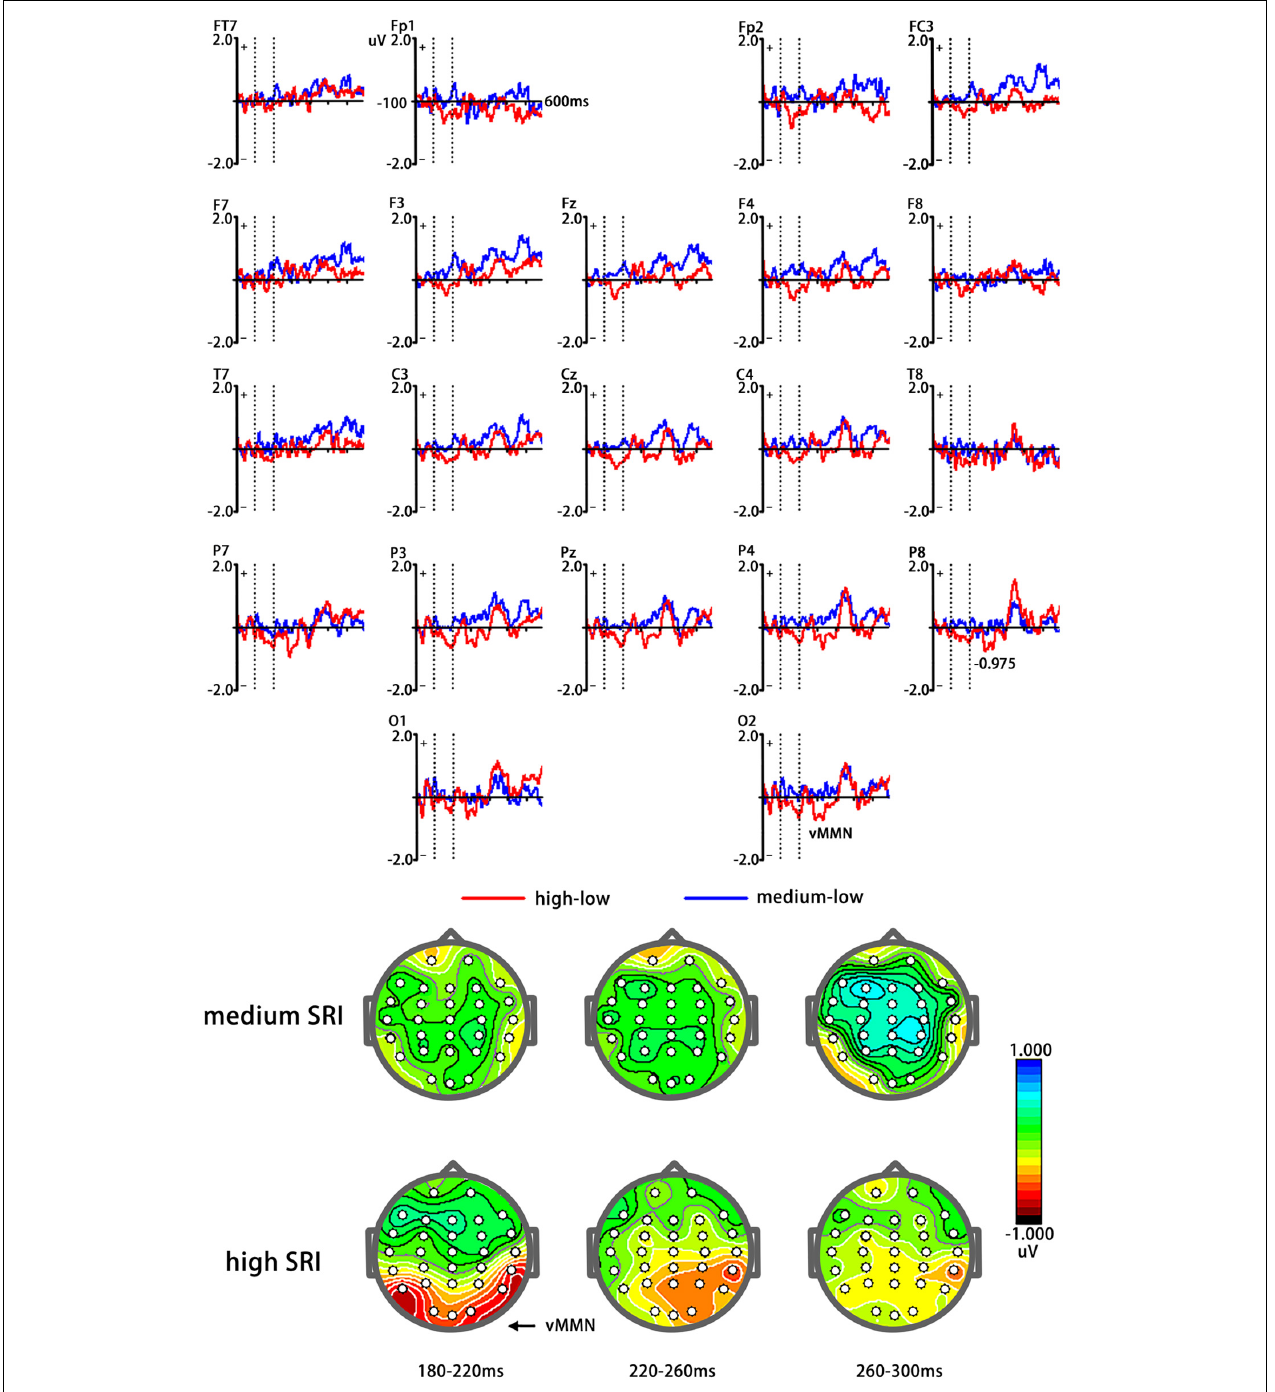
FIGURE 3 | Visual mismatch negativity elicited by high (birthplace) and medium (current city) SRI, respectively [ (A) top ]. Red curve represents vMMN elicited by high SRI, whereas blue curve represents vMMN elicited by medium SRI. A topographic map of vMMN elicited by high (birthplace) and medium (current city) SRI [ (B) bottom